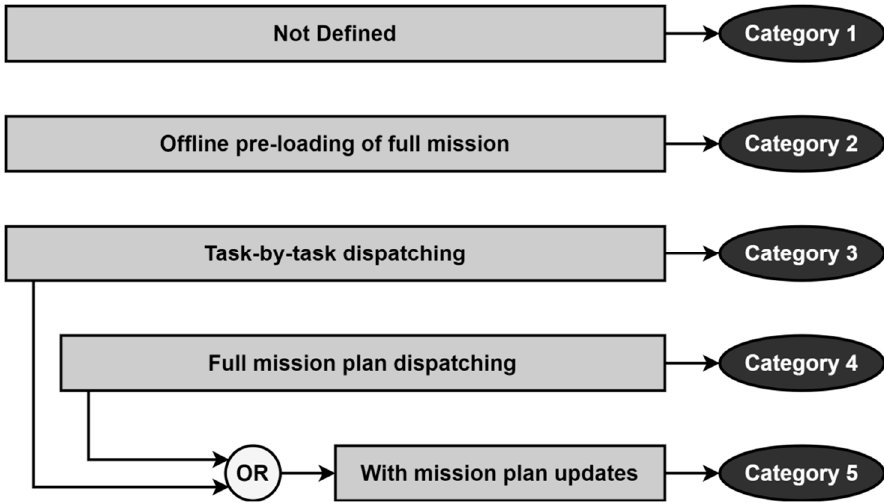
Figure 8. Diagram for the assignment of categories for the mission plan dispatching feature. Table 5. Mission plan dispatching and execution assessment.